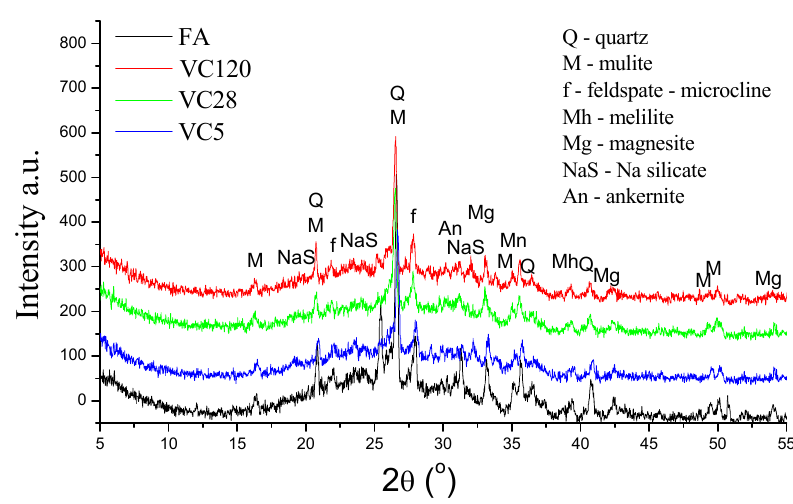
Figure 4 . XRD diffractograms of FA and VCRs .